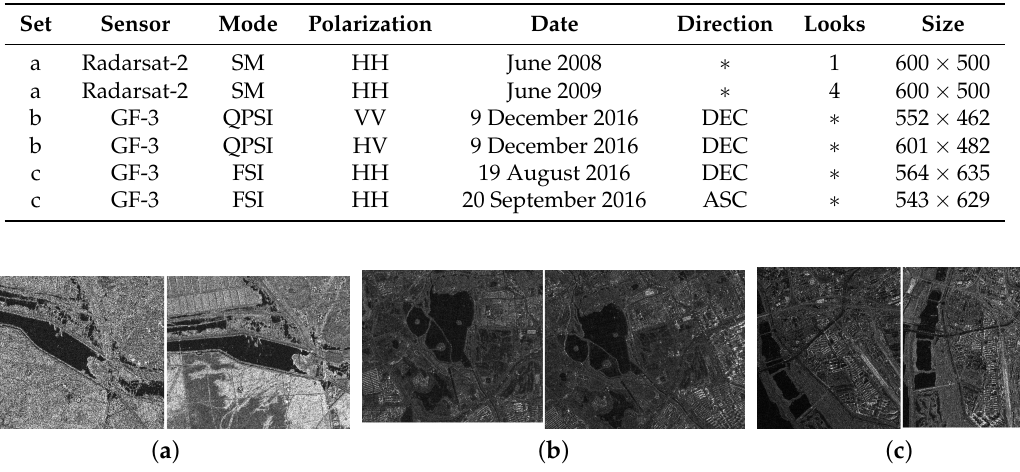
Table 1. Image pairs and their characteristics. QPSI, Quad Polarization StripMap; SM, StripMap; FSI, Fine StripMap; DEC, Descending; ASC, Ascending; GF, GaoFen.